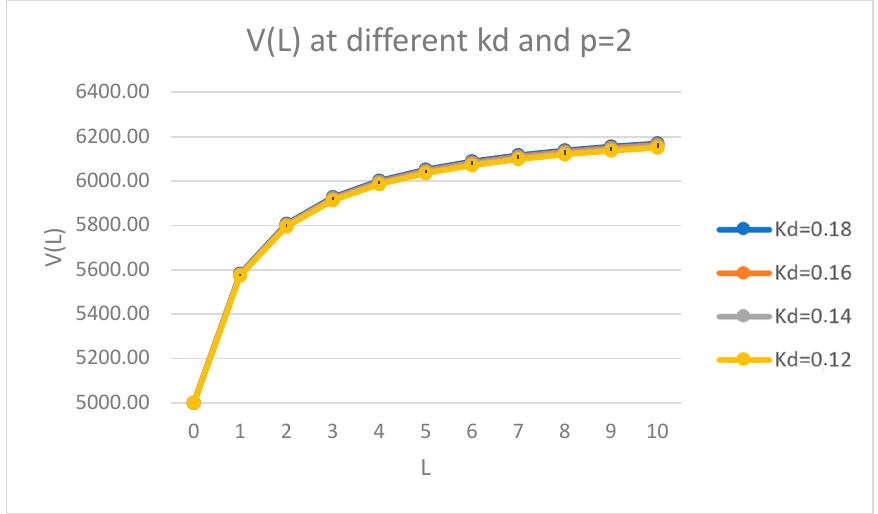
Figure 10. Dependence of the company capitalization, V , on leverage level L at different debt cost. k d (12%; 14%; 16%; 18%) and fixed frequency of payments of tax on profit p =